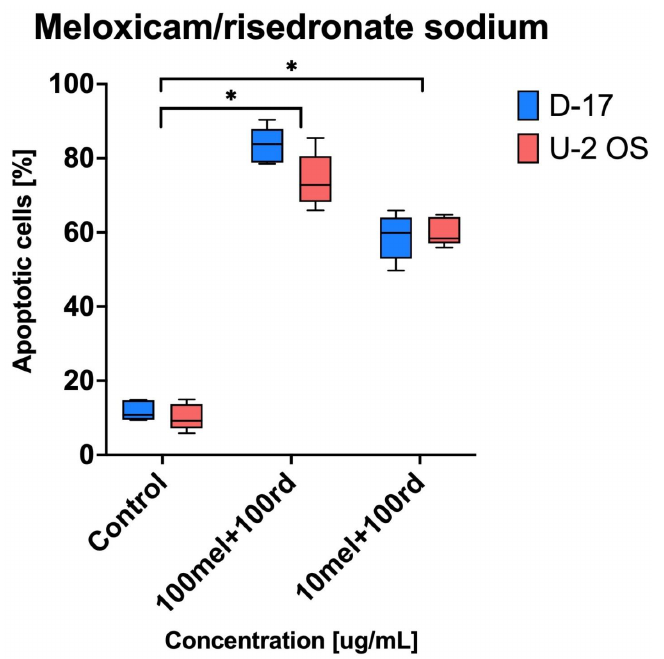
Figure 4. The pro-apoptotic effect on canine (D-17) and human (U-2 OS) osteosarcoma triggered with risedronate sodium/meloxicam combinations (* p < 0.05). The meloxicam and risedronate sodium combinations 100 mel + 100 rd and 10 mel + 100 rd compared to the negative (control) showed the statistically significant differences. The cytotoxic effect caused by 100 mel + 100 rd was stronger than induced by 10 mel + 100 rd. 4. Discussion Meloxicam is one of the most common non-steroidal anti-inflammatory drugs (NSAID) used in veterinary medicine, while in humans its application is less popular. It is often assumed that this substance exhibits anticancer activity against different types of tumors, both in humans and animals, as confirmed for hepatocellular carcinoma (HCC), non-small cell lung cancer, bladder cancer, colon cancer, or OS [25 – 30]. Studies assessing the use of meloxicam against cells from the established canine (D- 17) and human (U-2 OS) OS lines demonstrated significantly higher viability and EC 50 of human than canine OS cells (Table 3). This finding confirmed that canine OS cells are less resistant to the cytotoxic activity of meloxicam ( p < 0.05) than humans OS cell lines (Table 4). This phenomenon may be due to the moderate-selective inhibition of COX-2 in